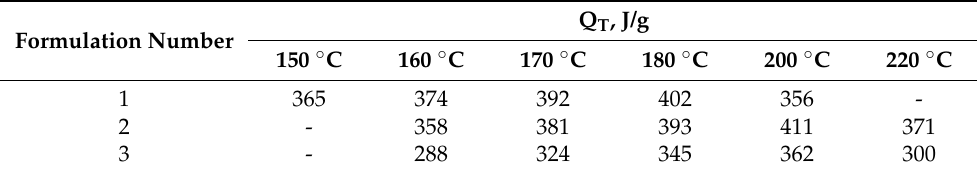
Table 2. The enthalpies of curing for isotherms at 150, 160, 170, 180, 200 ◦ C for formulations 1–3. Formulation